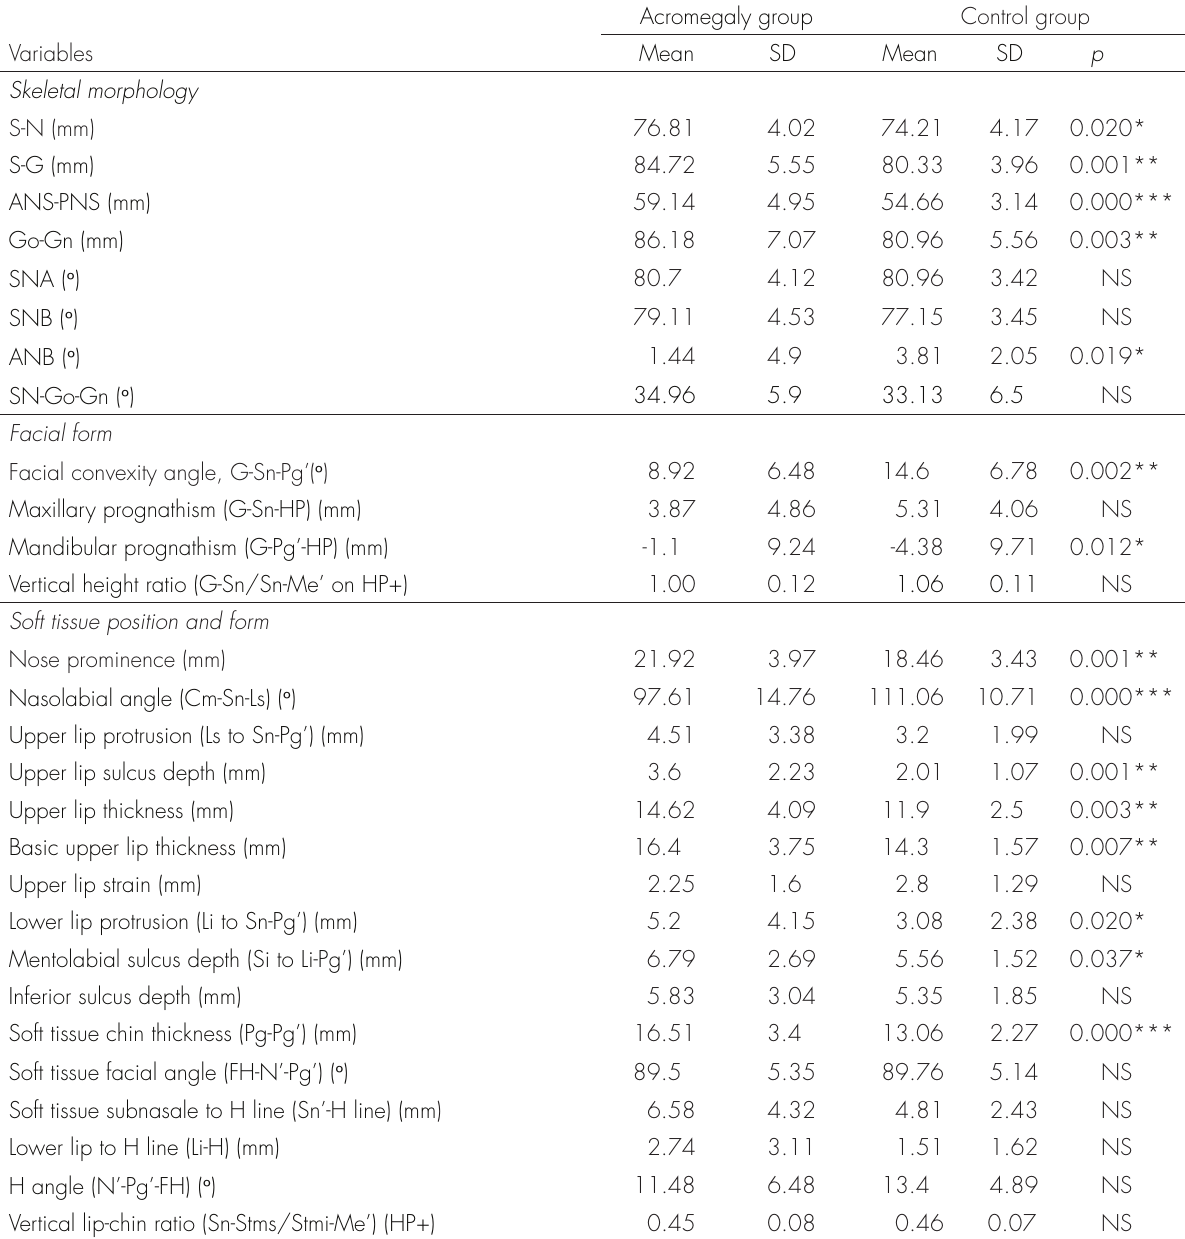
Table II. Skeletal and soft tissue cephalometric variables and comparisons between the two